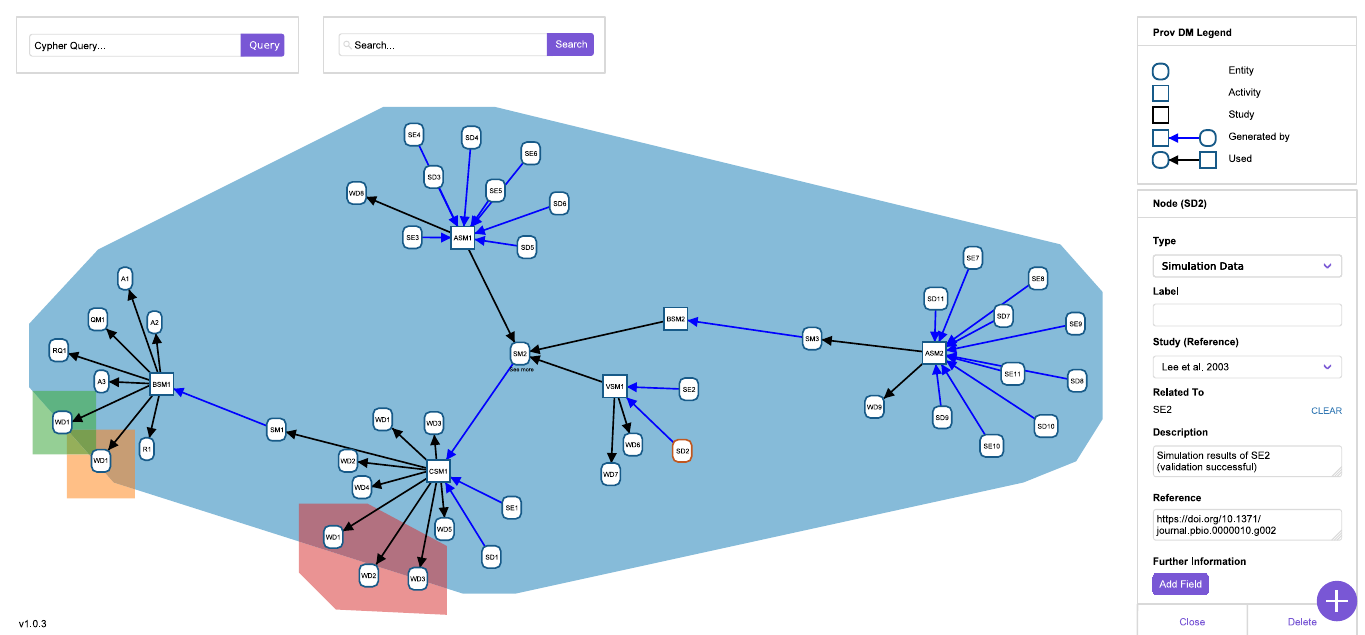
Fig 4. Screenshot of WebProv. This screenshot shows the provenance graph of the study by Lee et al. (2003) [28] with additional entities from three other studies [64– 66], which are automatically colored differently. The node SD2 has been clicked on, which opens a box on the right with the stored and editable metadata.